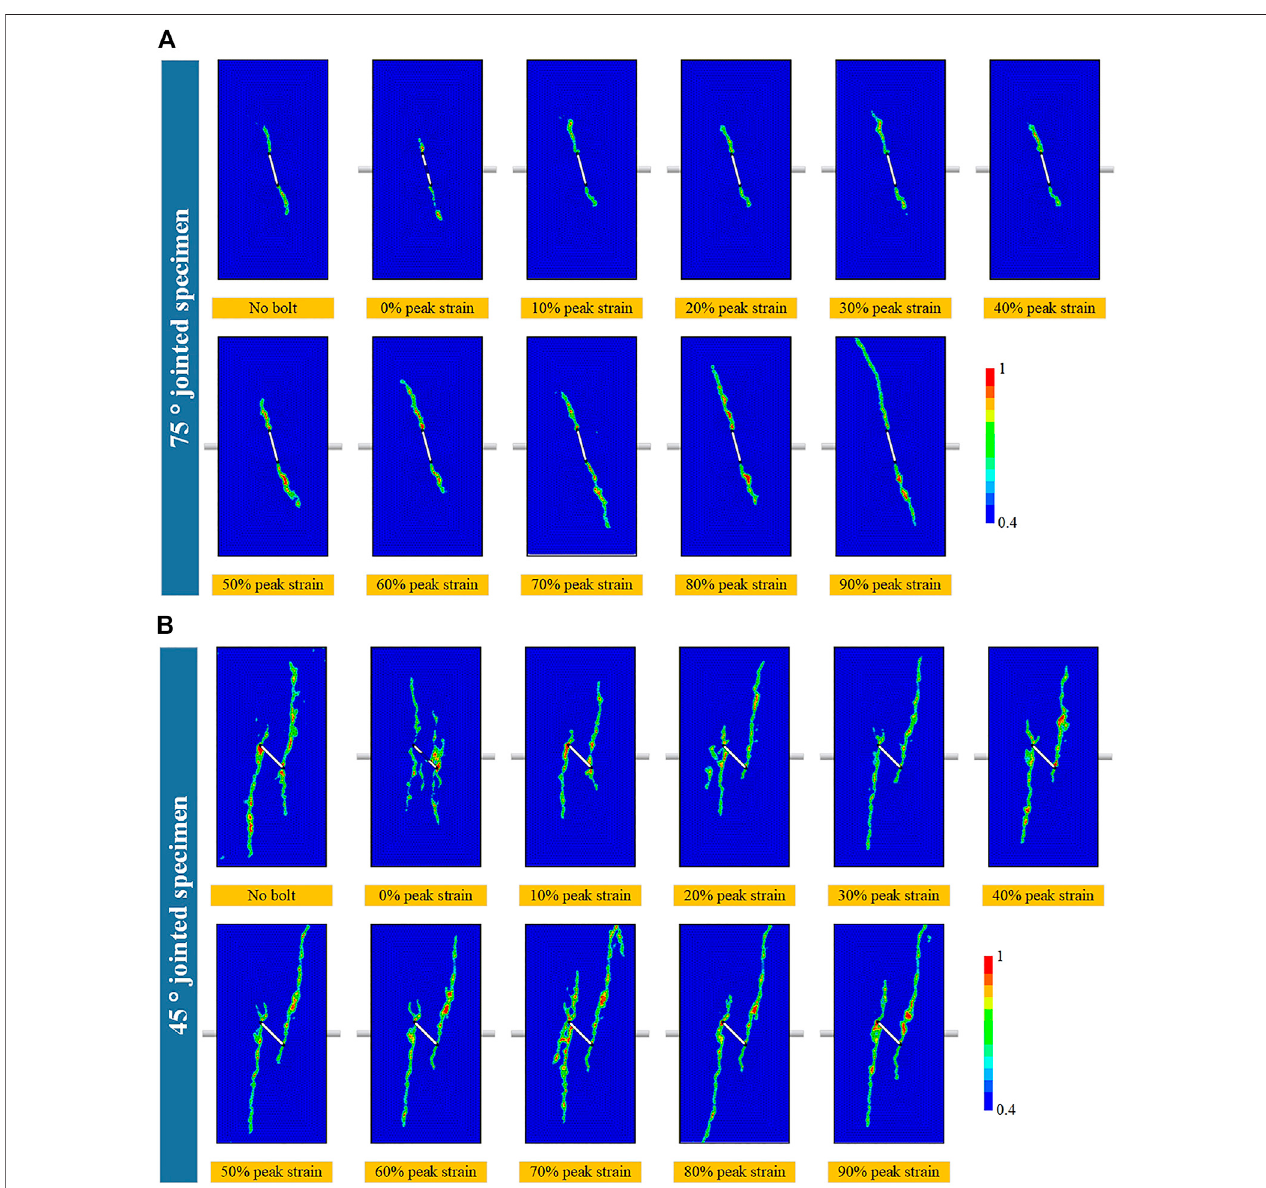
FIGURE14| Damagemodeofjointedspecimensafterboltingunderdifferentstrainstates:75 ° jointedandboltedjointedspecimens (A) and45 ° jointedandbolted jointed specimens (B) .